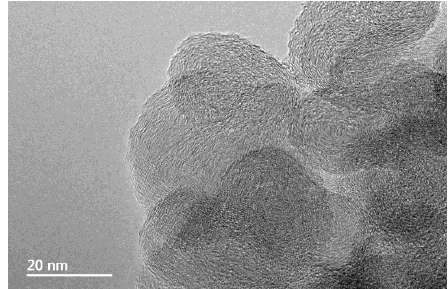
Figure 1. The transmission electron microscope (TEM) image of carbon nanoparticles.